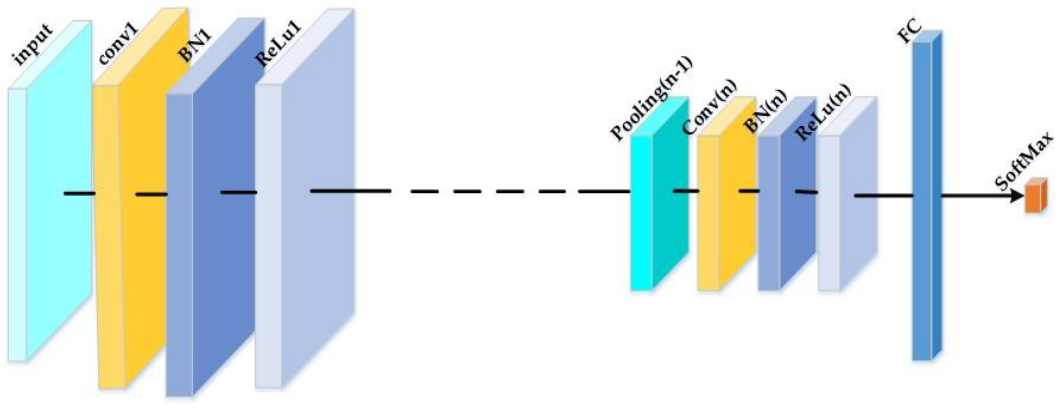
Figure 1. Typical architecture of a CNN.